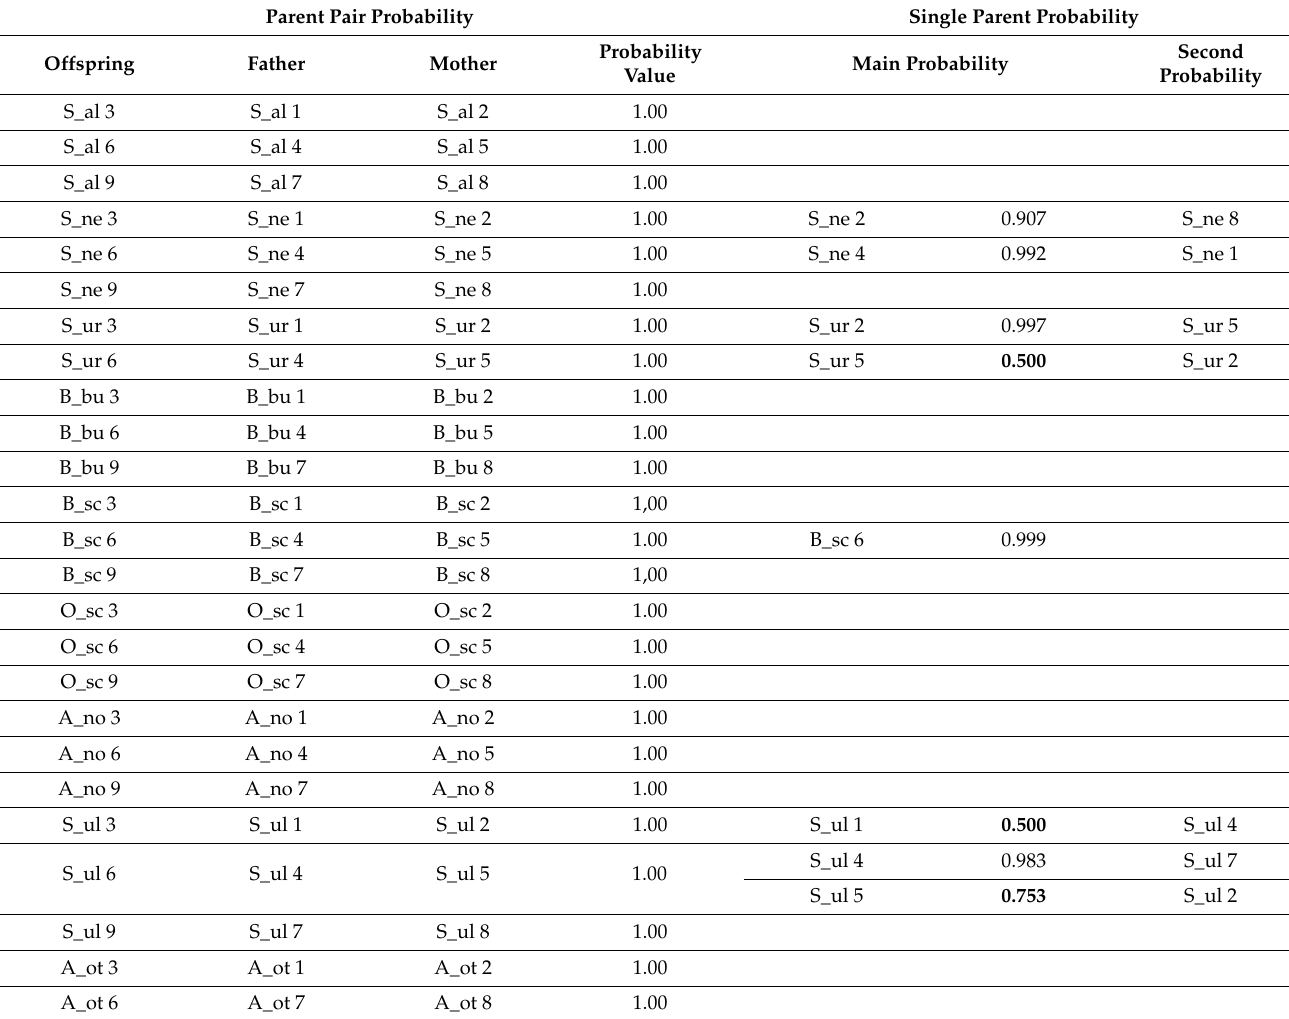
Table 5. Parental assignment values from Colony: the lowest values were recovered when the one-parent assignment was tested. In the table, misallocation or low assignment probabilities are highlighted in bold.